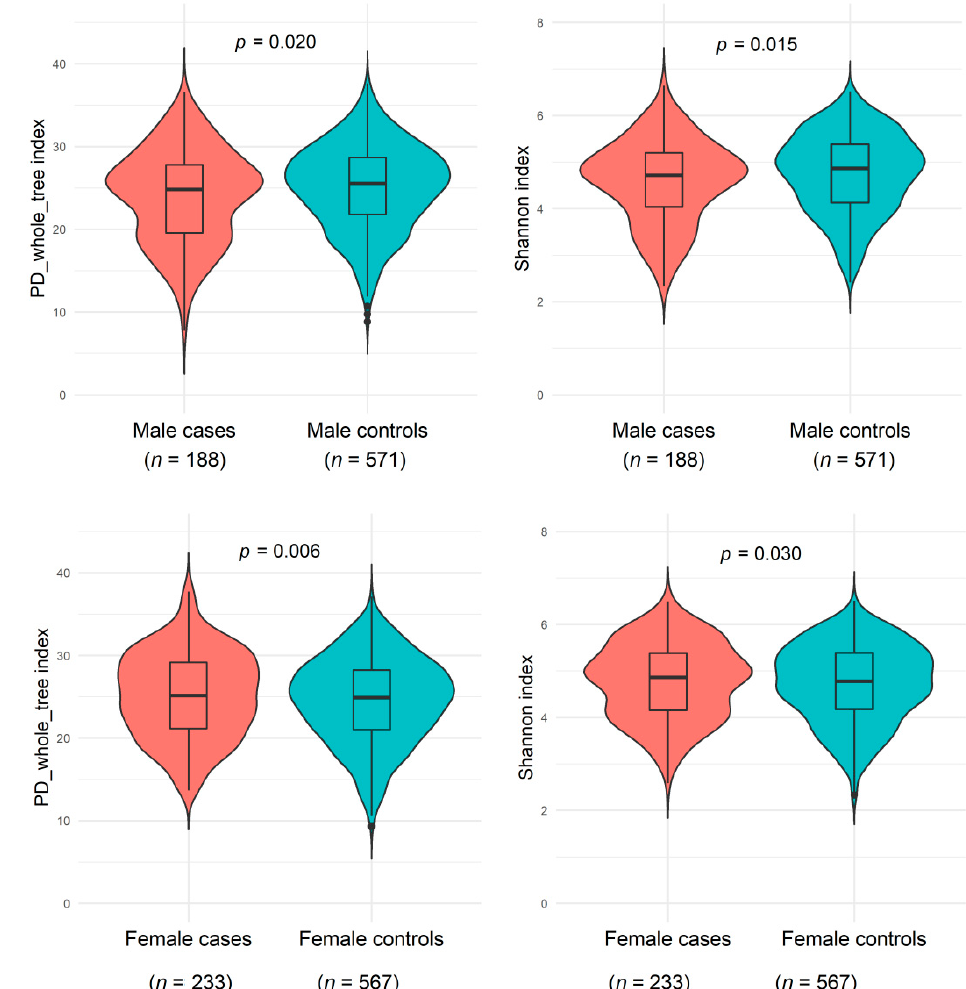
Figure 1. Gut microbiome α‐ diversity indexes (PD_whole_tree_distance and Shannon) between non ‐ alcoholic fatty liver disease and healthy controls among males from the Shanghai Men’s Health Study (SMHS) and females from the Shanghai Women’s Health Study (SWHS). General linear regression was conducted, adjusting for age at stool collection, the season of stool collection, body mass index, waist ‐ to ‐ hip ratio, education, income, smoking status, alcohol drinking status, phys ‐ ical activity, total energy intake, fat intake, bowel movement frequency, history of hypertension, history of dyslipidemia, and sequencing batch. Abbreviation: PD, phylogenetic